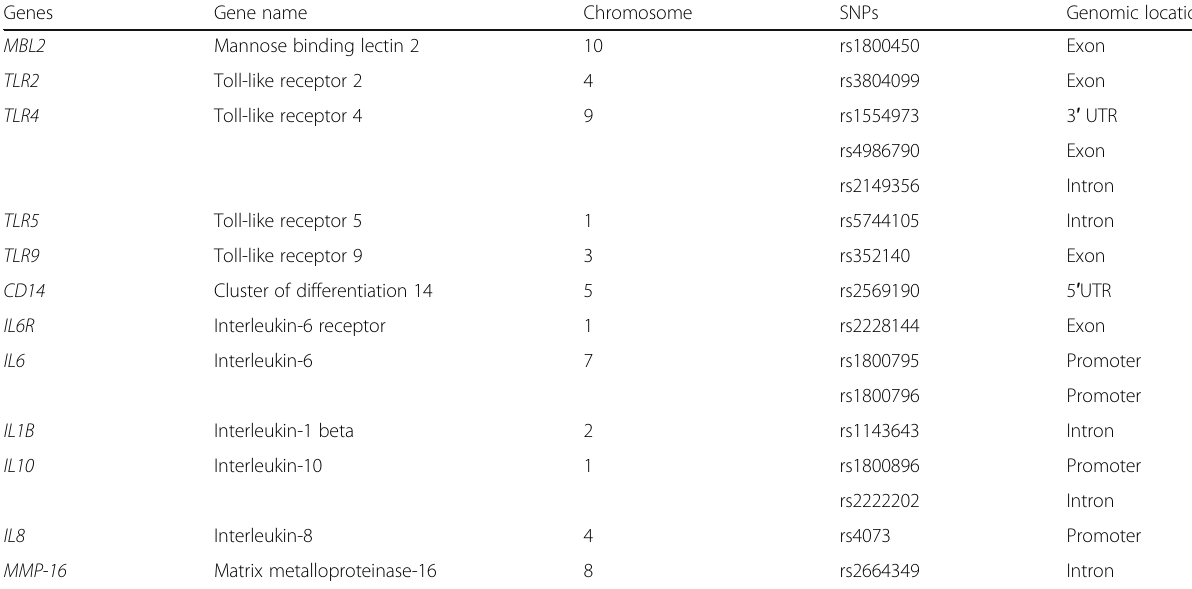
Table 2 Information for 16 candidate SNPs in innate immune system genes